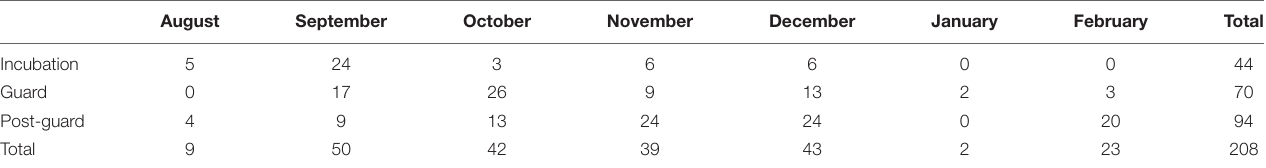
TABLE 1 | Number of analyzed samples across months and breeding stages of the 2015/2016 breeding season at Phillip